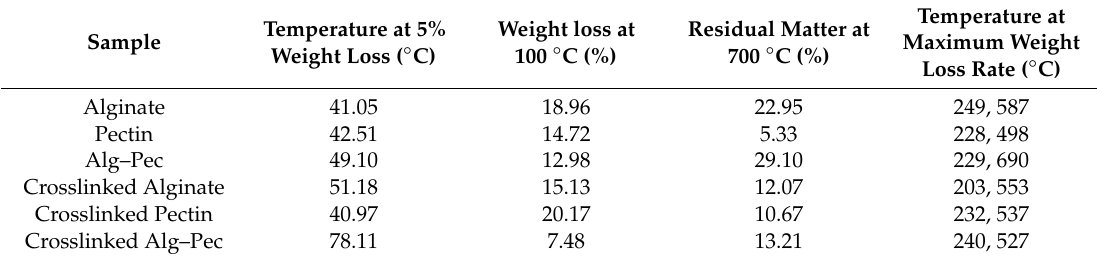
Table 5. Thermal stability parameters of alginate, pectin, and their biocomposite films before and after crosslinking.